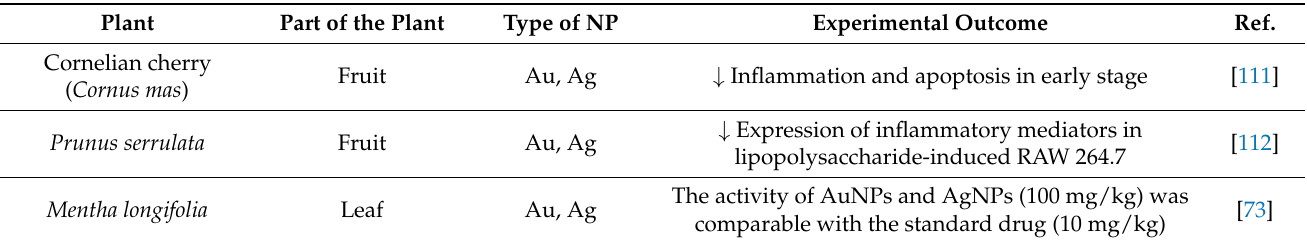
Table 4. Plant-based gold and silver nanoparticles as anti-inflammation